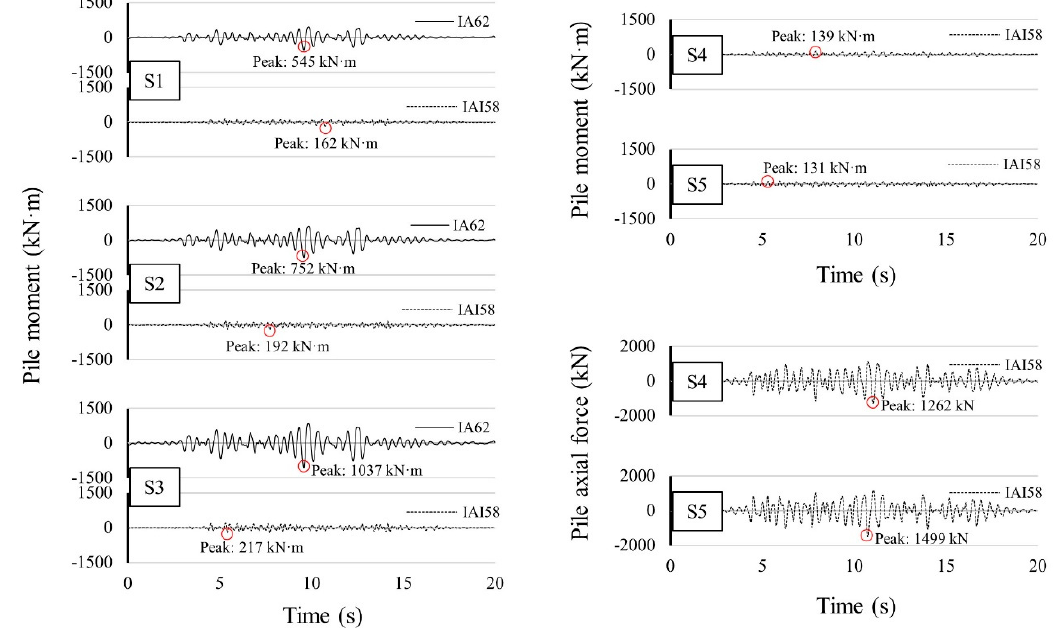
Figure 9. Pile moment and axial force time histories of inclined ground model (0.12 g) (scaled to the